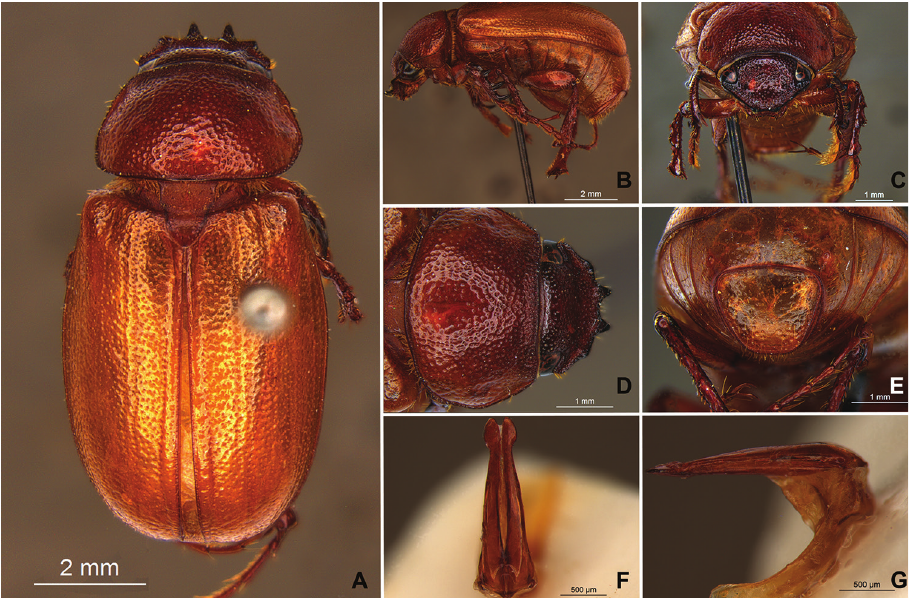
Figure 83. Liogenys freyi Cherman, sp. n. A Dorsal view B Lateral view C Frontal view D Clypeus and pronotum E Pygidium F Parameres, dorsal view G Parameres, lateral